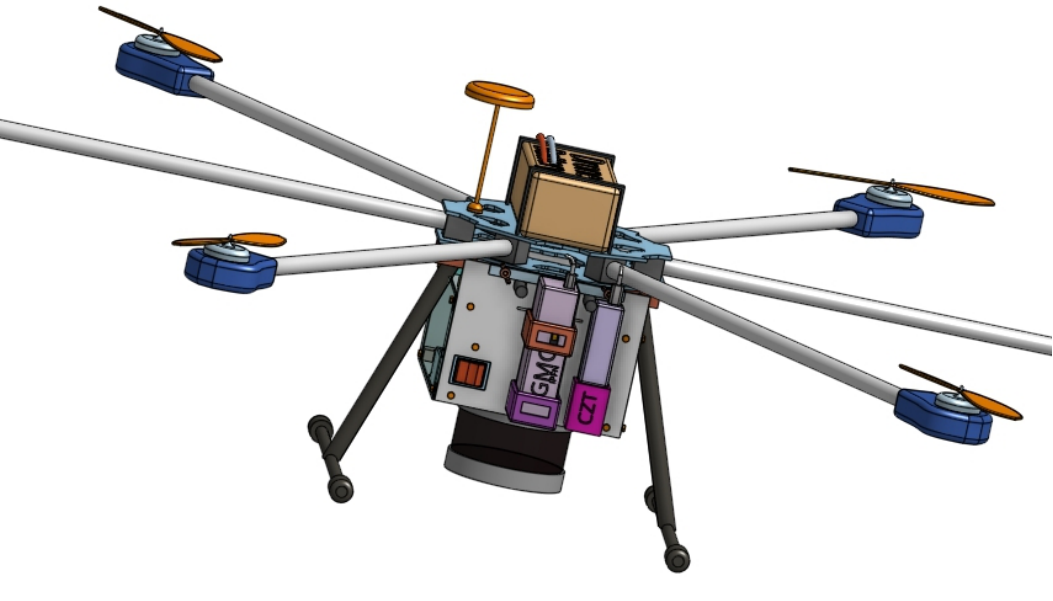
Figure 12. CAD image of the hexarotor and sensor-box underneath, encompassing GMC and CZT sensors as well as a LIDAR on the